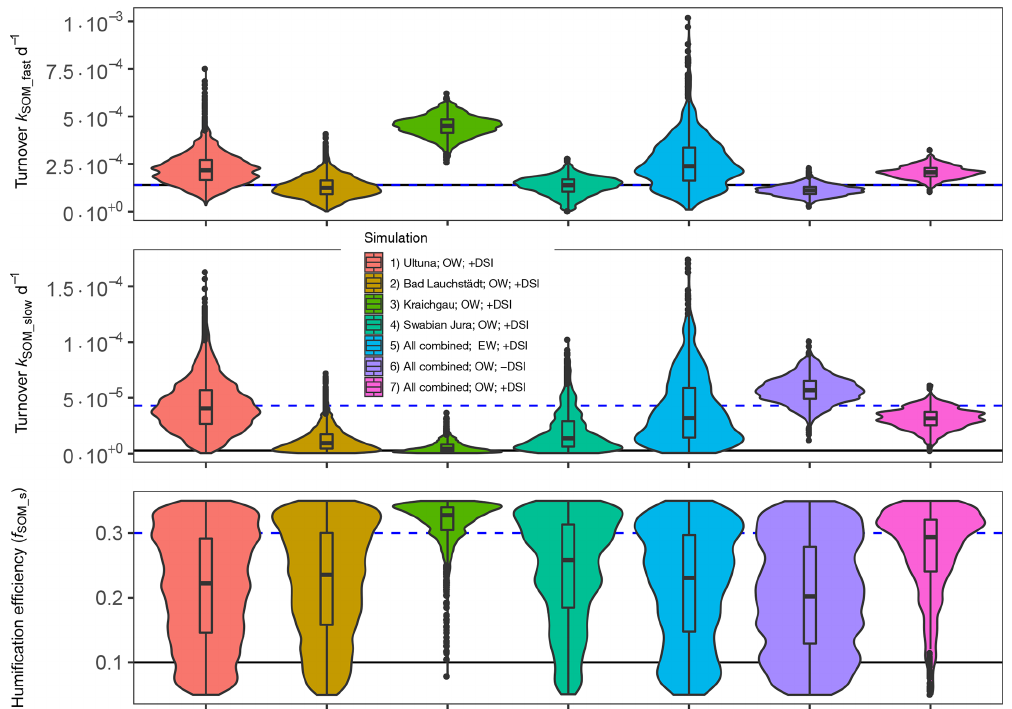
Figure 5. Violin plots of the parameter distributions, obtained by the Bayesian calibration using only the individual sites (1–4) and all sites combined (5–7) with different weighing schemes (OW, original weight; EW, equal weight calibration; ± DSI indicates whether the DSI data were used for calibration). The black line corresponds to the parameters of Mueller et al. (1997) and the dashed blue line to the parameters of Bruun et al. (2003). Note that the turnover k SOM_fast parameter (top of the figure) is the same in both Mueller et al. (1997) and Bruun et al.